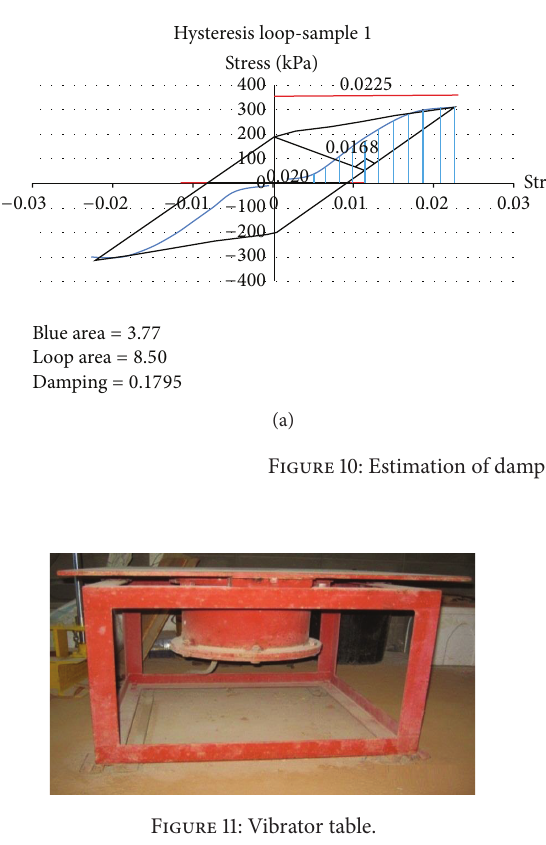
Figure 9: Damping definition and hysteretic and equivalent bilinear stress-strain relationships for soil: (a) stress-strain curves; (b) bilinear idealization [23].